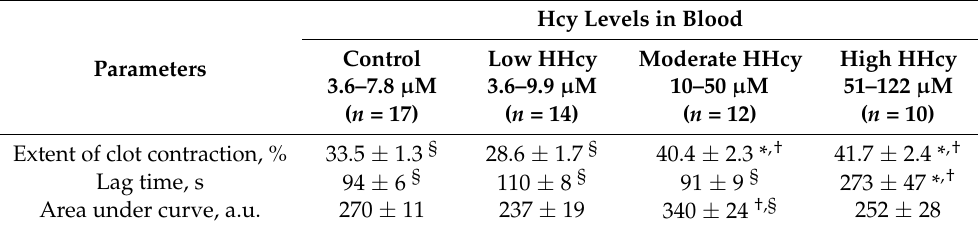
Table 2. Clot contraction parameters in clots made from the blood of control and HHcy rats with low, moderate and high Hcy